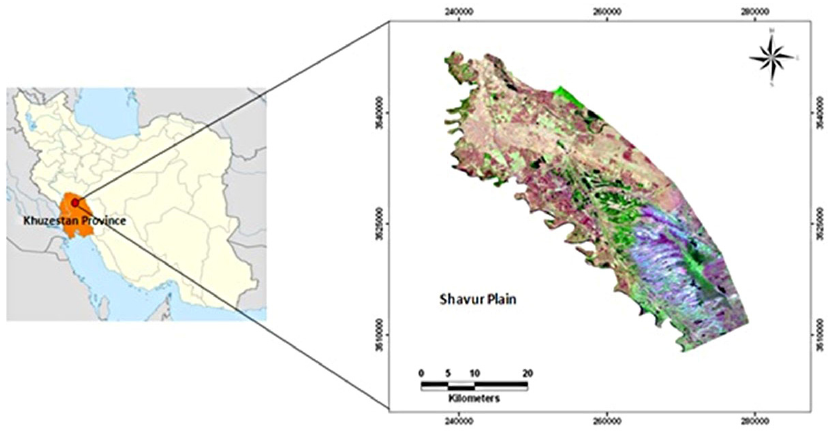
Figure 1. Location of the study area, Shavur Plain in Iran (WGS 84, UTM-Zone 38 N). Table 1. Summary of parameters for land suitability classification in the study area. Parameters